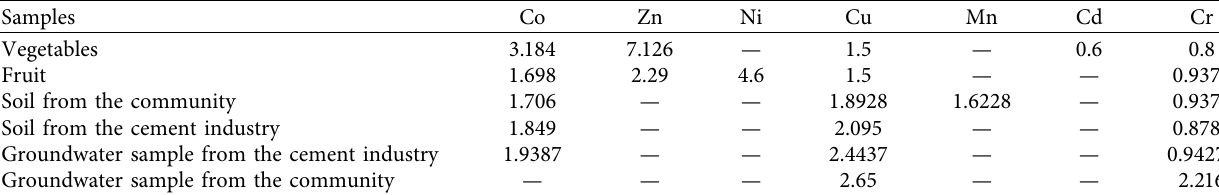
Table 2: Mean concentration of heavy metals (ppm).